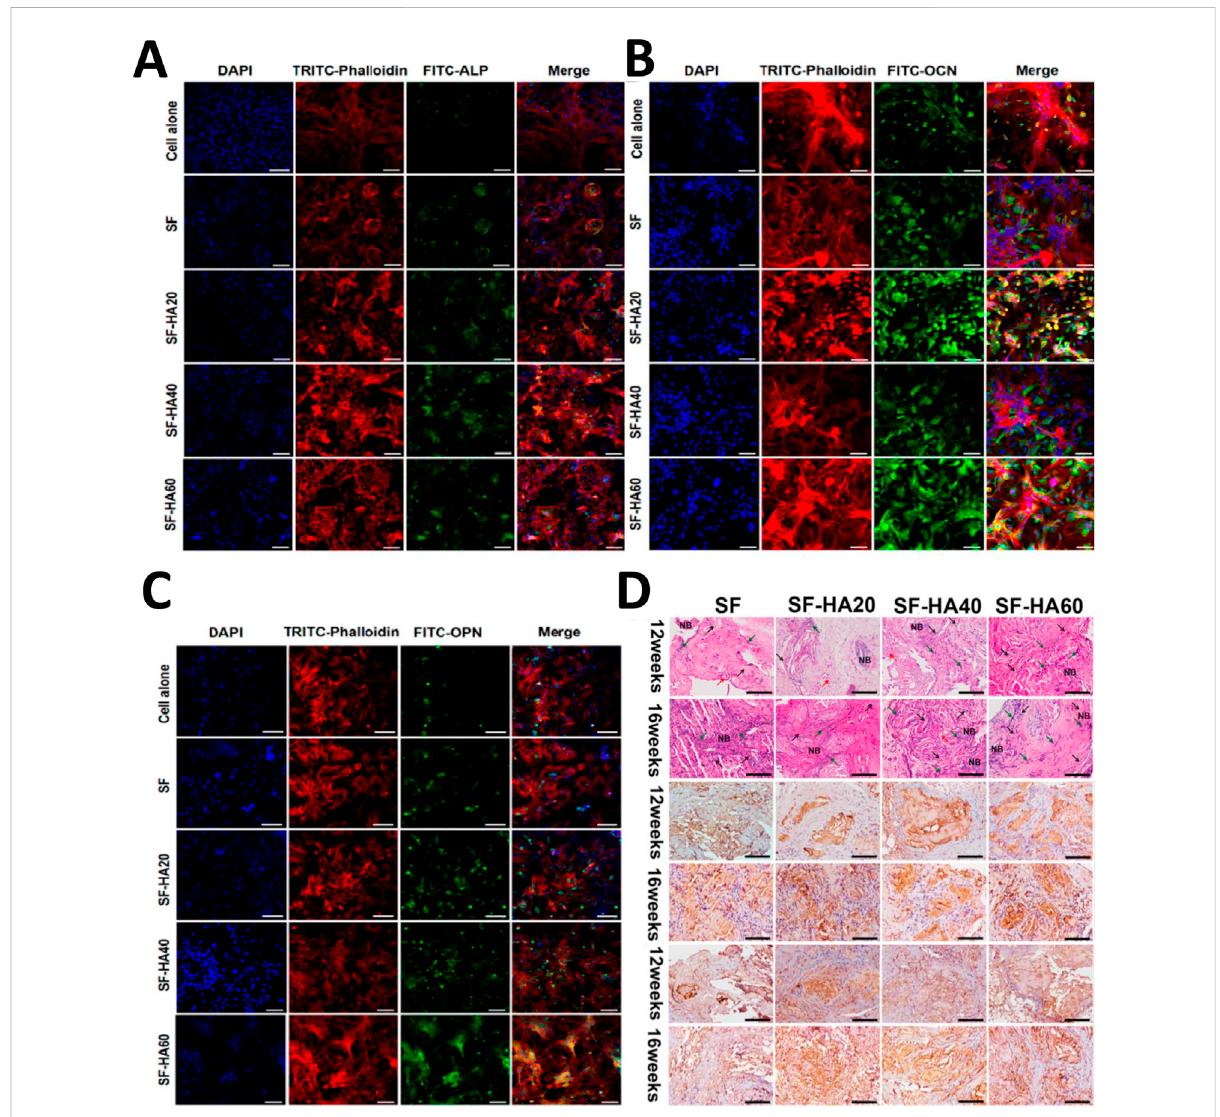
FIGURE 4 Immuno fl uorescence staining and histological analysis of osteogenic capacity in vitro and in vivo . (A) ALP expression after 7 days in different hydrogels. (B) OCN expression after 21 days in different hydrogels. (C) OPN expression after 21 days in different hydrogels. The nucleus was stained blue by DAPI and the F-actin was stained red by tetramethylrhodamine (TRITC) conjugated to phalloidin, while ALP, OCN, and OPN were stained greenbyantibodiesconjugatedwith fl uoresceinisothiocyanate(FITC). (D)